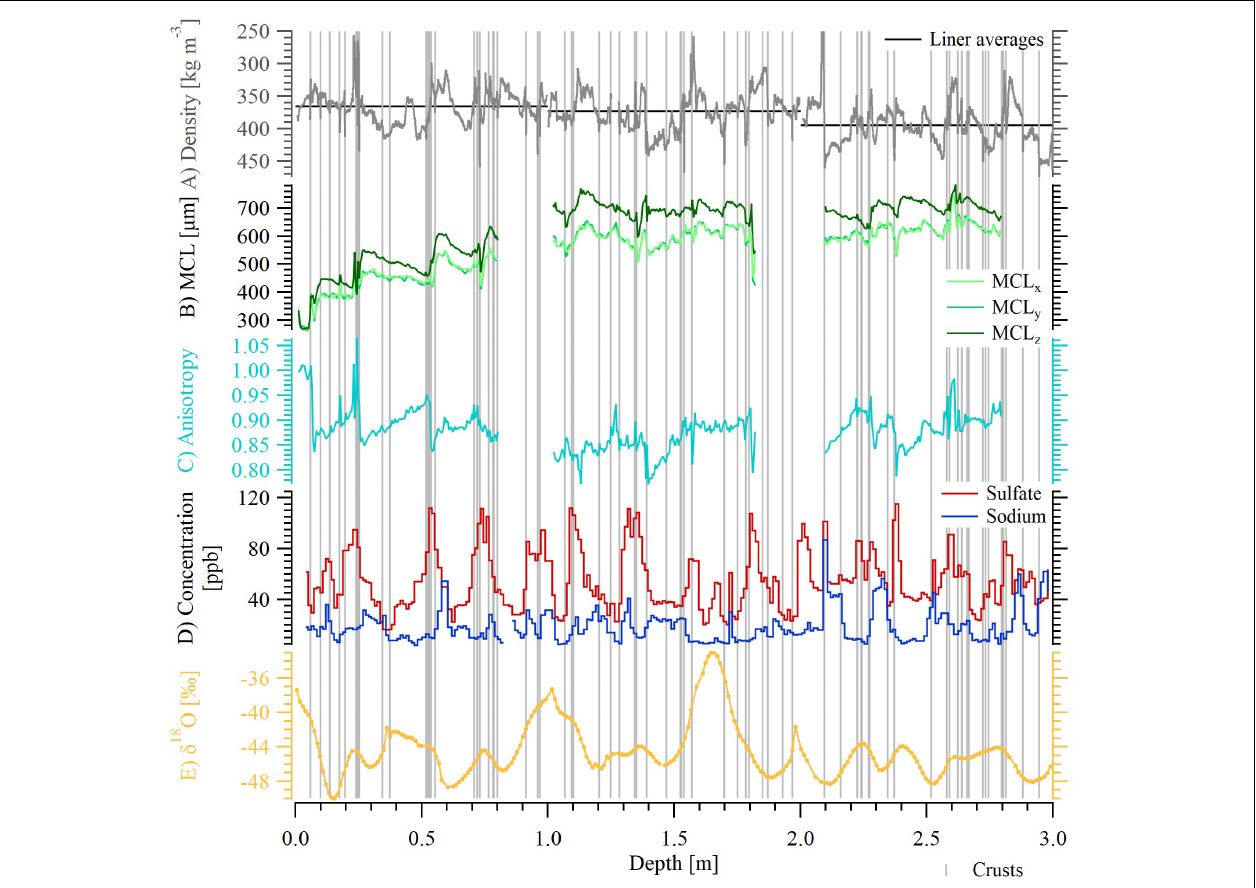
FIGURE 2 | Microstructure, trace elements, and isotopic composition displayed against depth from the single snow profile near Kohnen Station. (A) Density retrieved from a 2D radioscopic scan composite, and liner averages, note the reversed axis. (B) Mean chord lengths along x -, y -, and z -axis (MCL X , MCL Y , MCL Z ) of the ice phase based on a 3D volume scan, color code according to the legend. (C) Geometric anisotropy based on a 3D volume scan and derived from MCL. (D) Total sulfate (red) and sodium (dark blue) concentrations from discrete measurements. (E) Stable water isotopic δ 18 O measured discretely; surface crust positions are indicated by light gray